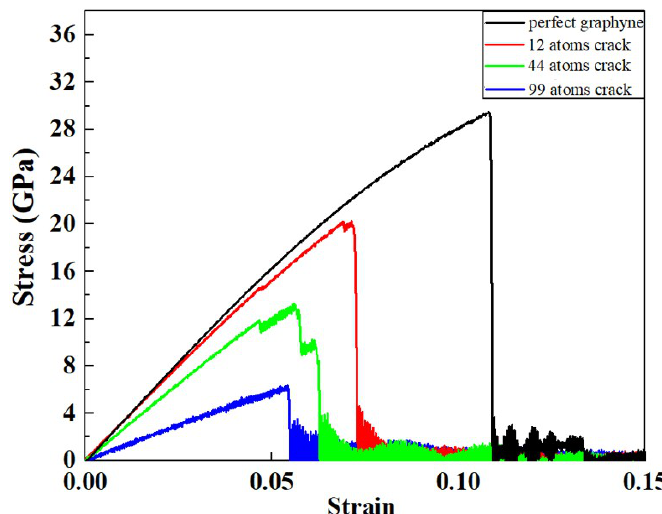
Figure 5. Stress-strain curves of four types of graphyne under tensile loading.